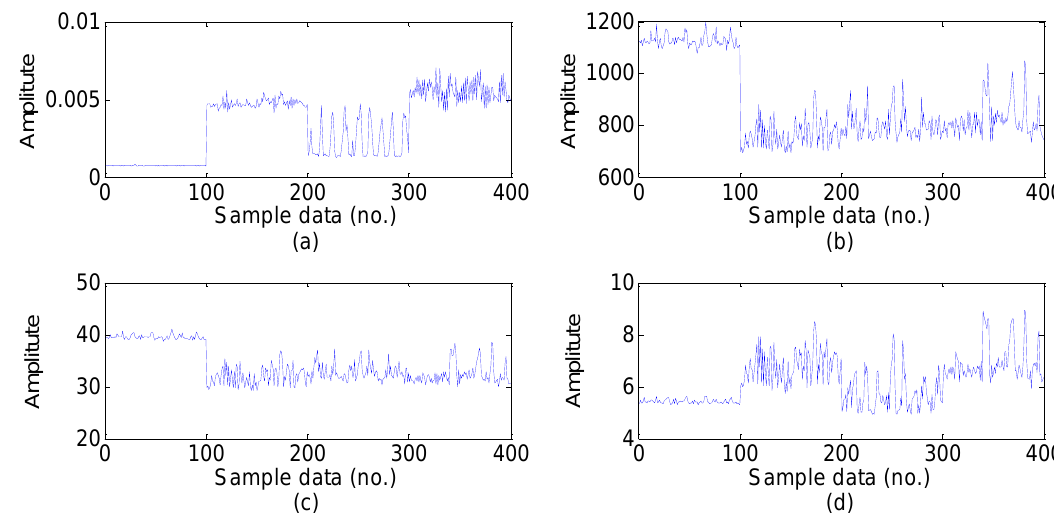
Figure 7. The four frequency-domain features value in the dataset: ( a ) Mean frequency; ( b ) Frequency center; ( c ) Root mean square frequency. ( d ) Root variance frequency (Note: sample data No.1–100, 101–200, 201–300, 301–400 represent normal, inner race fault, ball fault and outer race faults, respectively).